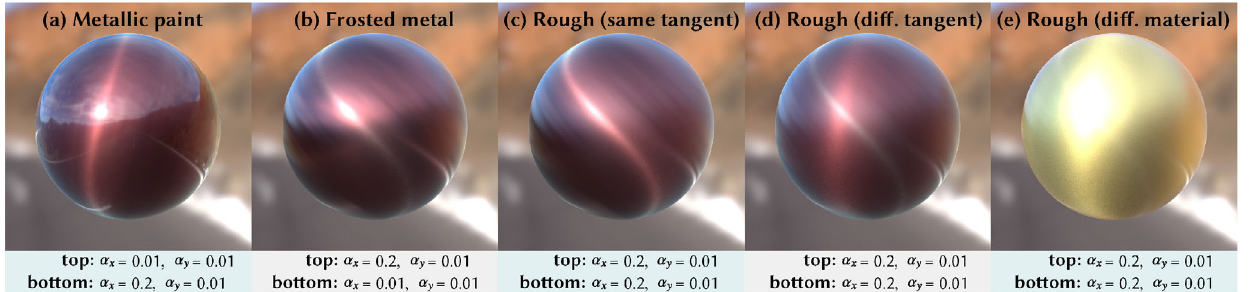
Fig. 4 Layered materials rendered using the proposed method. Each layer of the materials has an anisotropic NDF, and it can be defined on a tangent vector field, which differs from layer to layer. The materials are comprised of dielectric top layers with a refractive index of 1 . 49 for (a)–(e), and metallic bottom layers with a complex refractive index of (1+1i , 1+0i , 1+0i) for (a)–(d) and (0 . 143+3 . 983i , 0 . 373+2 . 387i , 1 . 444+1 . 602i) for (e).